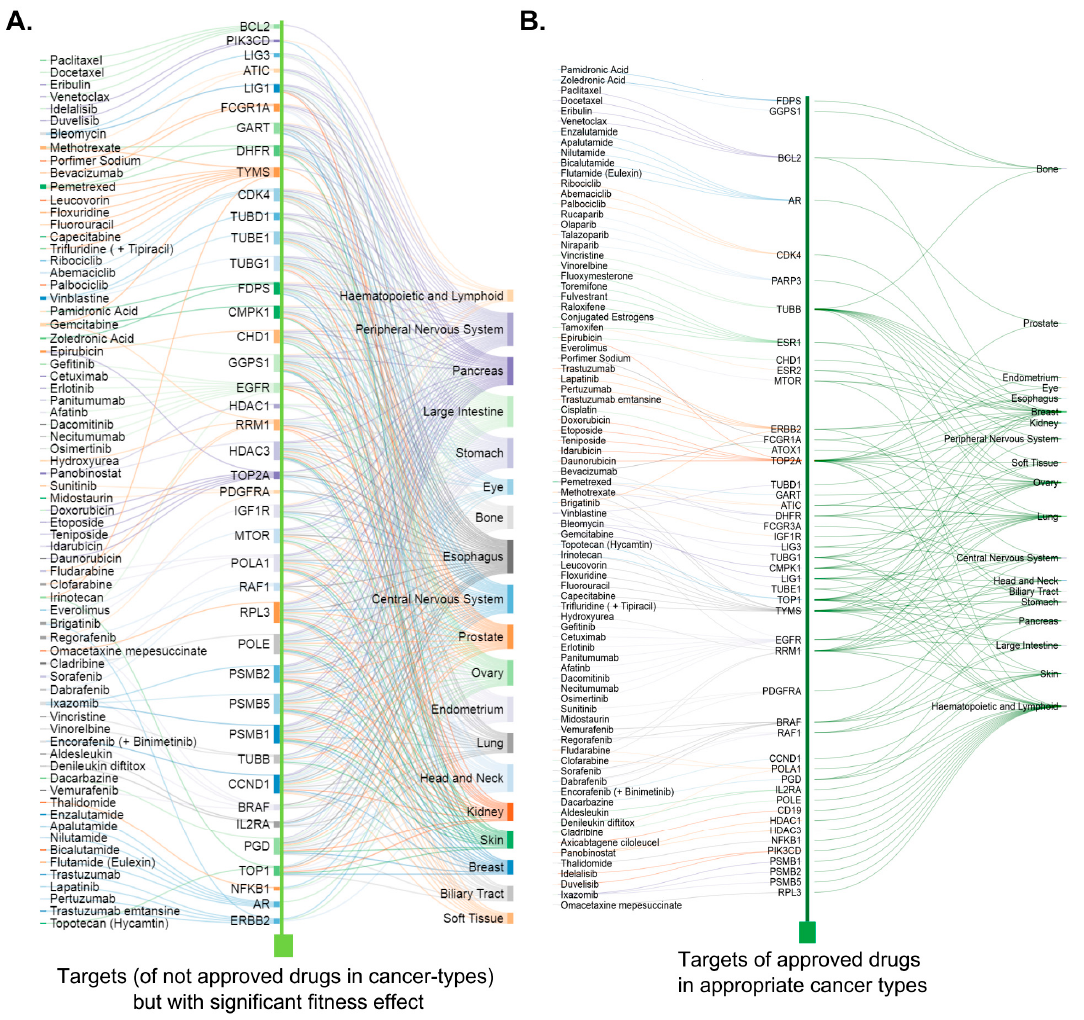
Figure 7. Relationship between the cellular targets and/or effectors of oncology drugs and cancer-types. Overall summary of the relationship noticed in the present study between the cancer types and cellular targets or effectors with significant fitness-dependency for which indicated drugs targeting these molecules are not approved ( A ) or approved ( B ).